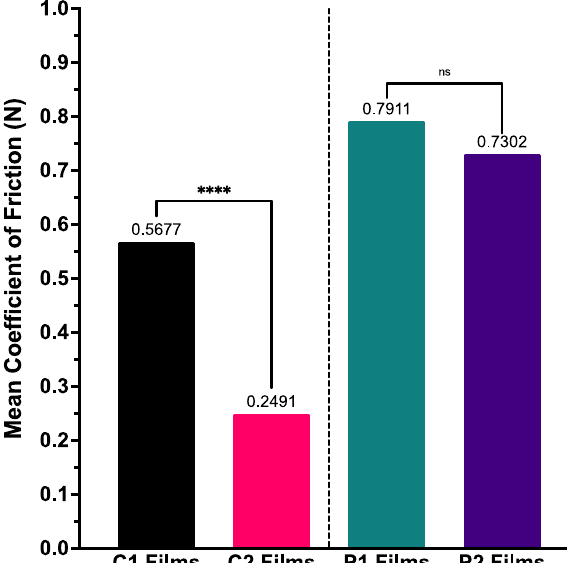
Figure 5. Mean coefficient of friction calculated for ODF samples for BTM tribological testing ( n = 3), with one-way ANOVA statistical significance data displayed—**** ( p < 0.0001) and ns (not significant).